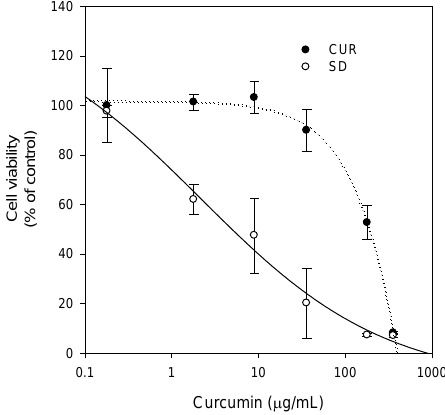
Figure 9. The effect of curcumin (CUR, ) or solid dispersion formulation (SD, ○ ) on viability of MDA-MB-231 cells. MTT assay was performed after 24 h incubation in the presence of curcumin (0.18, 1.8, 9, 36, 180 and 360 μg/mL), 10-fold amount of TPGS, and their solid dispersion formulation. Each data point represents the mean ± S.D. of three independent experiments.